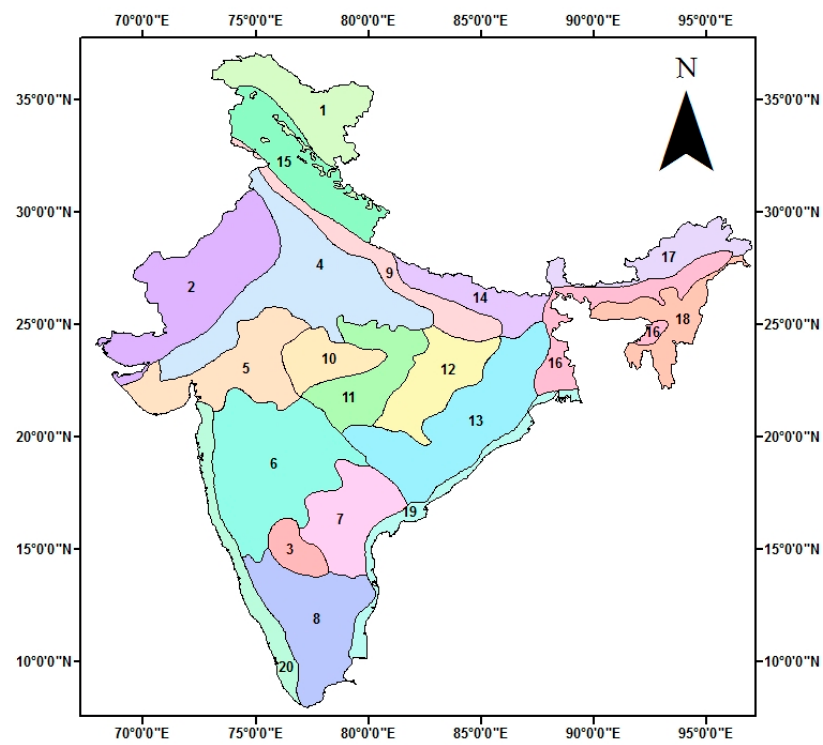
Figure 3. Map of the agro-ecological zones of India.